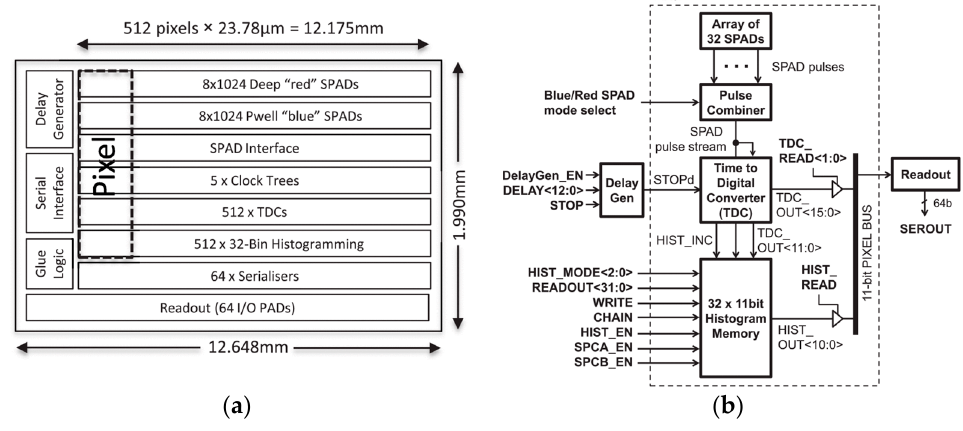
Figure 13 . ( a ) Sensor and ( b ) pixel block diagrams of the 512 × 16 SPAD Line Sensor